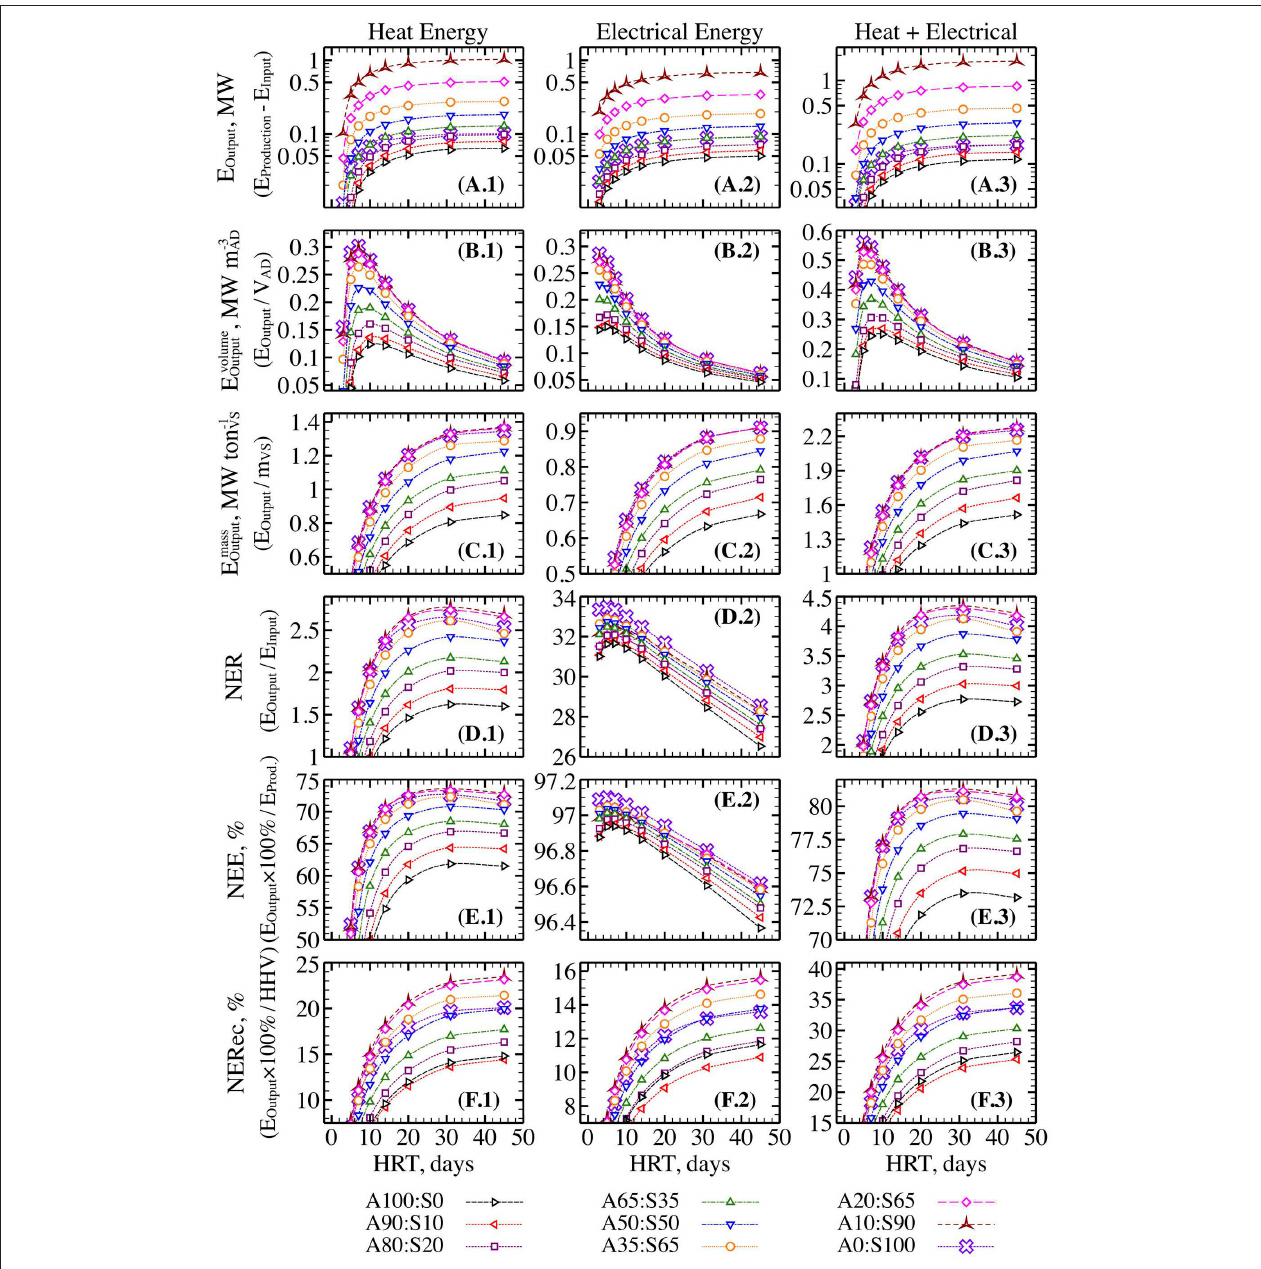
FIGURE 11 | (A–F) Effect of algae to sewage sludge co-digestion ratio on AD system energy